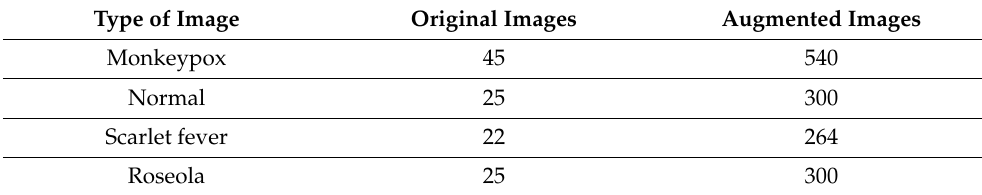
Table 2. Distribution of our original and augmented data.